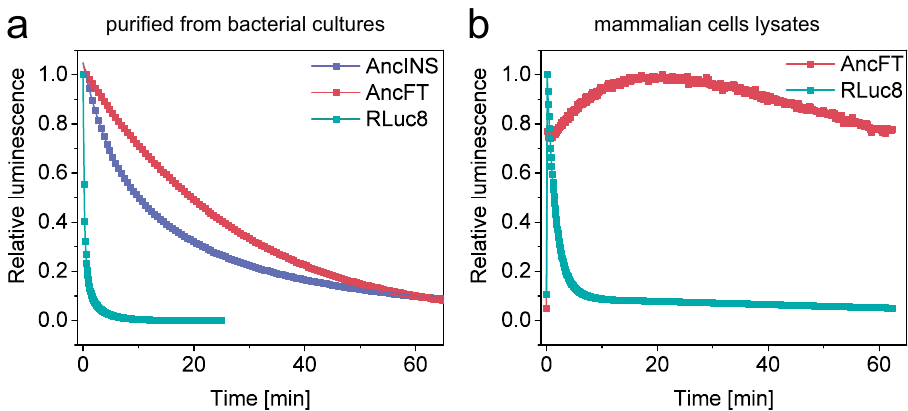
Fig. 7 Comparison of bioluminescence of enzymes puri fi ed from bacterial cultures and in lysates from mammalian cells. a Full decay kinetics of the conversion of 2.2 μ M CTZ by 50 nM of RLuc8, AncINS and AncFT puri fi ed from bacterial cultures. The data are presented as relative values to initial luminescence; Anc HLD-RLuc is not plotted due to low activity leading to large signal scattering. Solid lines represent the best fi t to the experimental data. Experiments were repeated independently three times with consistent results. b Bioluminescence signal steadiness in relative values in lysates from mammalian cells expressing AncFT and RLuc8. Experiments were repeated independently three times with consistent results. Activity was measured using the commercial Renilla luciferase assay kit (Promega) with 20 μ L of cell lysates and 100 μ L of assay buffer. Luminescence signal in lysates from mammalian cells expressing Anc HLD-RLuc and AncINS was not detectable under tested conditions. Source data is available as a Source data fi le for Fig.